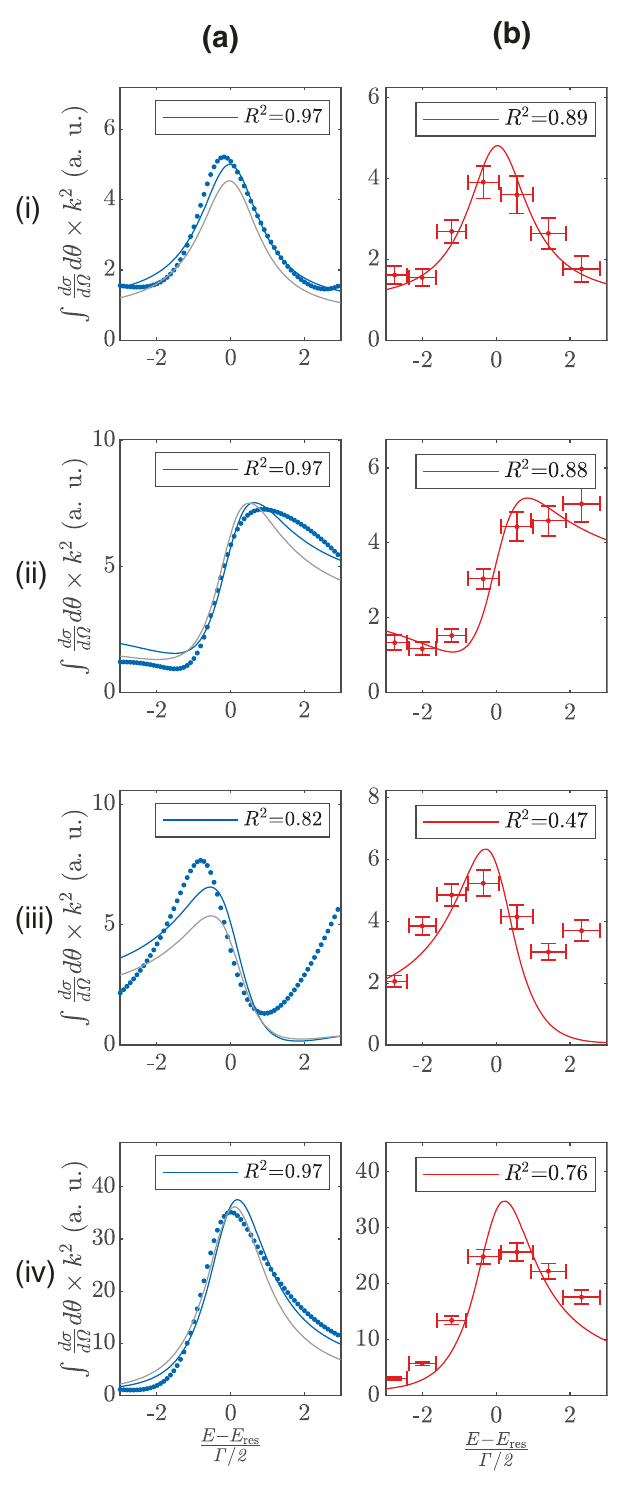
amplitude of the background extracted from the experimental data match well with the theoretically calculated values. Thus, our model determines the relative phase that is responsible for the measured shifts in the peak of the resonance pro fi le when angle- dependent cross sections are probed. This relative phase is the scattering analogue to the spectral phase that has been recovered before for Fano resonances that are external fi eld induced by attosecond XUV 31,32 or X-ray pulses 33 . In these examples, phase